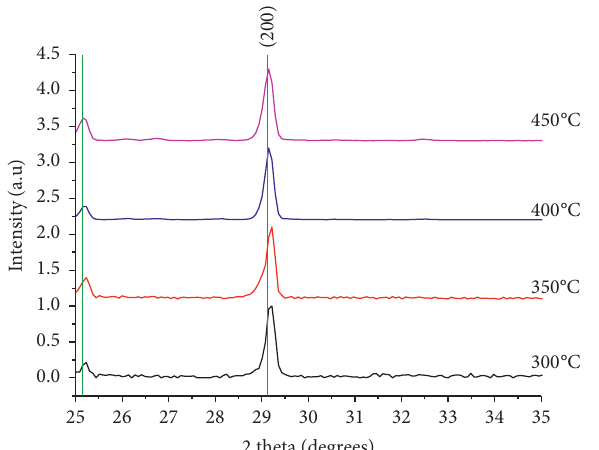
Figure 3: A stacked set of four p-XRD spectra showing the diffracting pattern of thin films deposited from [Pb((SeP i Pr complex at 300, 350, 400, and 450 ° C. The standard pattern is PbSe (ICDD